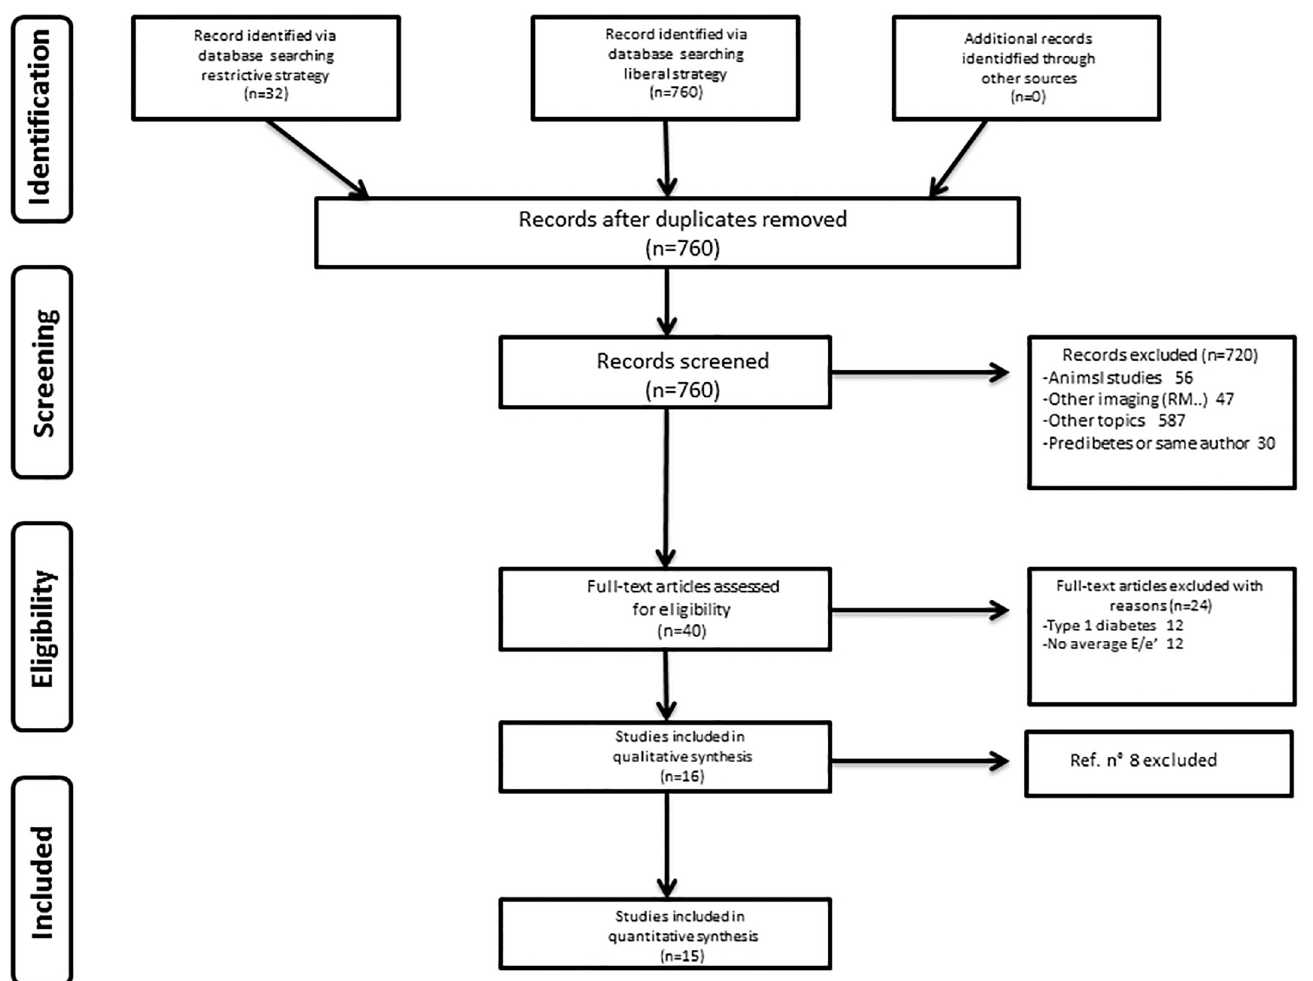
Fig 1. The PRISMA flowchart of the systematic search and quantitative